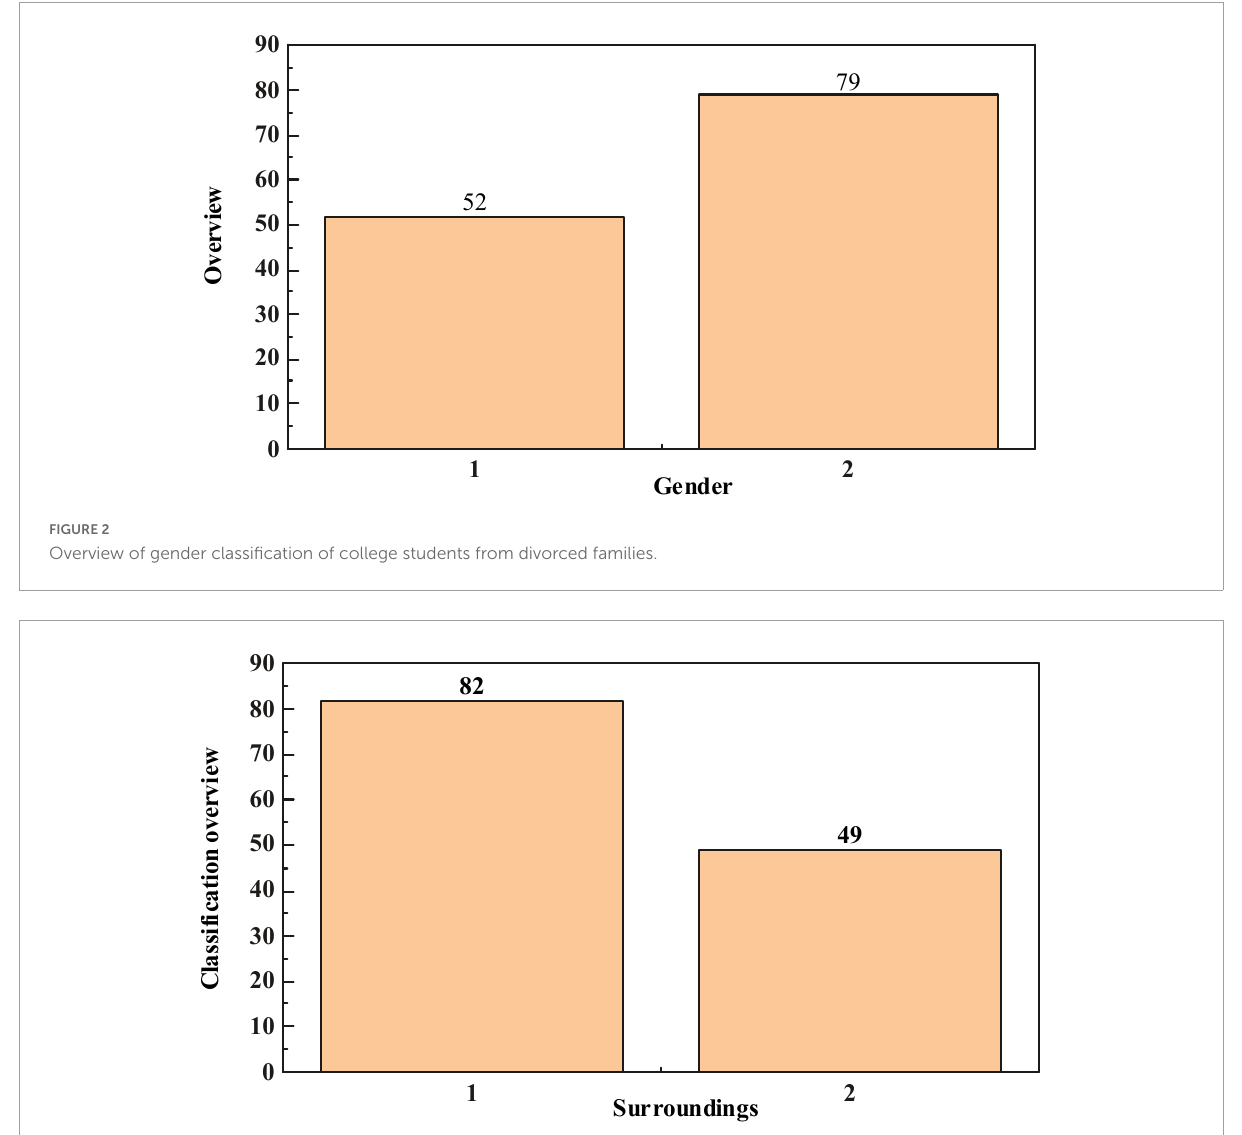
FIGURE3 Overview of the growth environment classification of college students from divorced